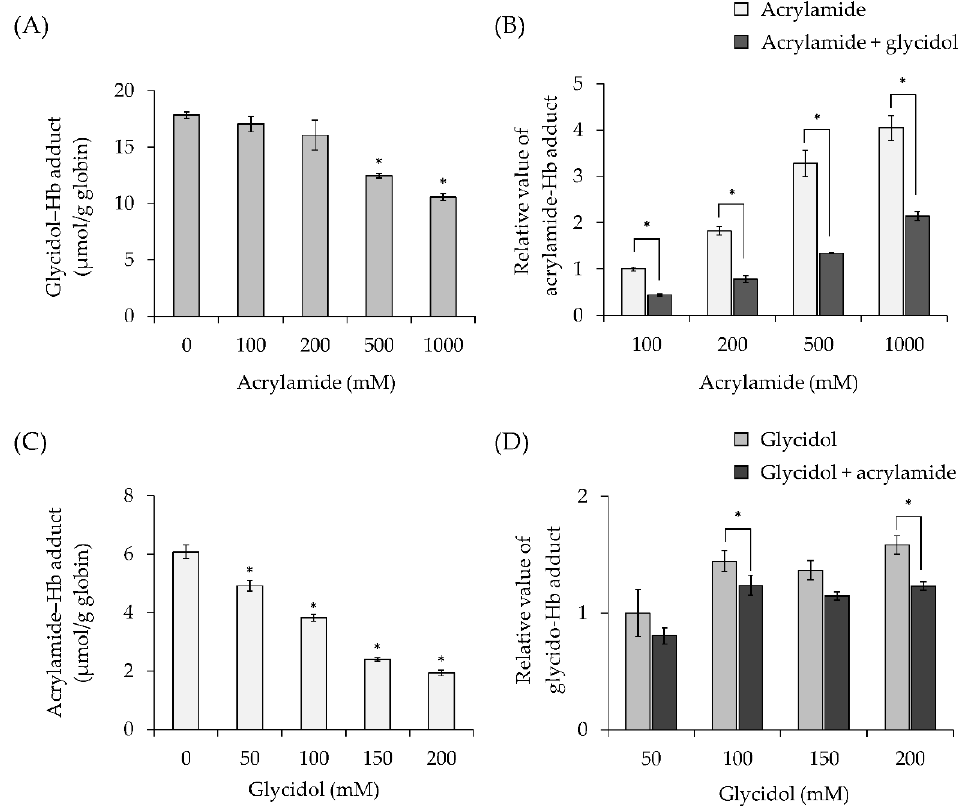
Figure 4. Effect of combined exposure to chemicals on Hb adduct formation (in vitro). ( A ) Effect of combined exposure to acrylamide on glycidol – Hb adduct formation. * The significance level was p < 0.05 compared with 0-mM acrylamide. ( B ) Relative value of acrylamide – Hb adduct formation with combined exposure of glycidol. * The significance level was p < 0.05 compared with the acrylamide alone at each concentration. ( C ) Effect of combined exposure to glycidol on acrylamide – Hb adduct formation. The significance level was p < 0.05 compared with 0-mM glycidol. ( D ) Relative value of glycidol – Hb adduct formation with combined exposure of acrylamide. * The significance level was p < 0.05 compared with glycidol alone at each concentration. The values represent the mean ± standard deviation (SD) of four independent